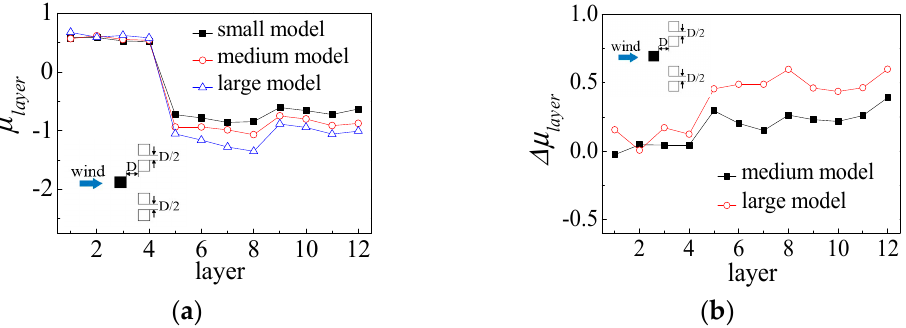
Figure 15. Wind tunnel test results of test condition 7. ( a ) Layer pressure coefficient; ( b ) relative error